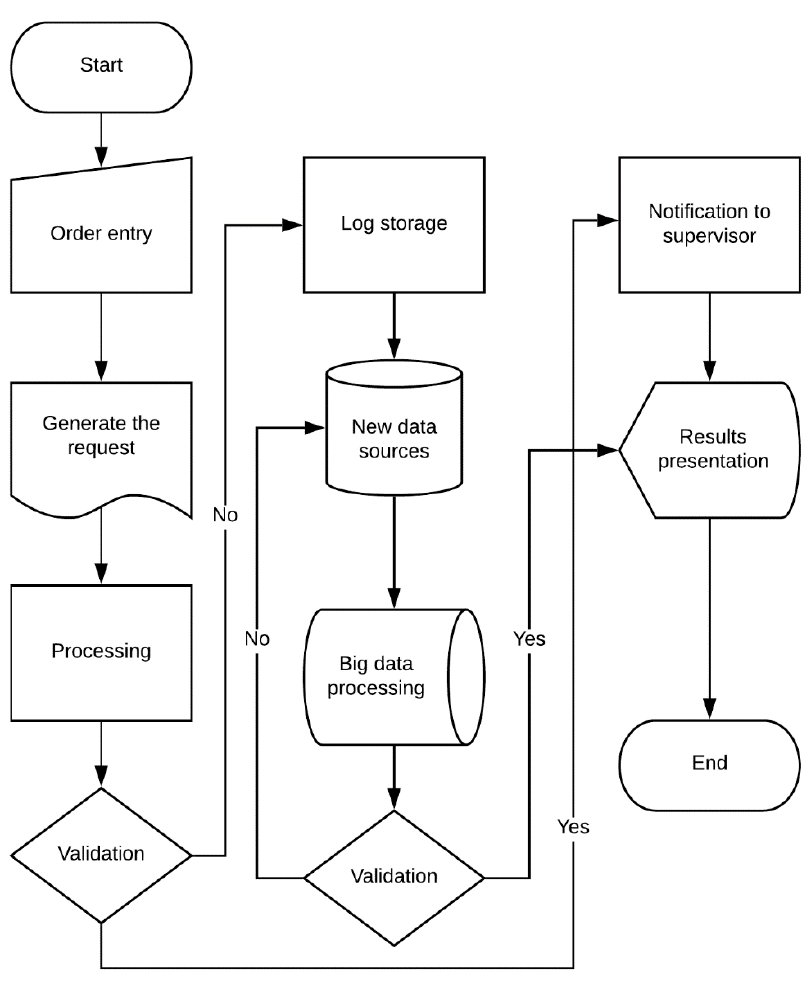
Figure 9. Block diagram for the data analysis process, through a Big Data framework.